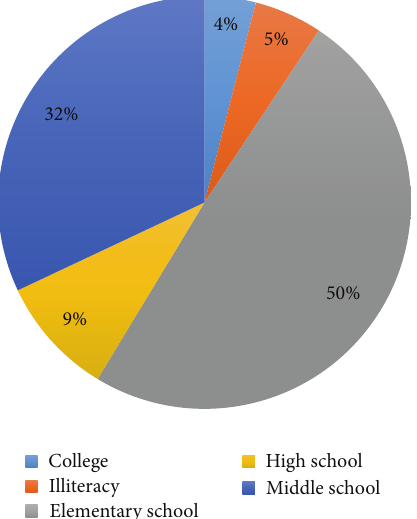
Figure 6: Age group of drivers in e-bike fatal crashes.